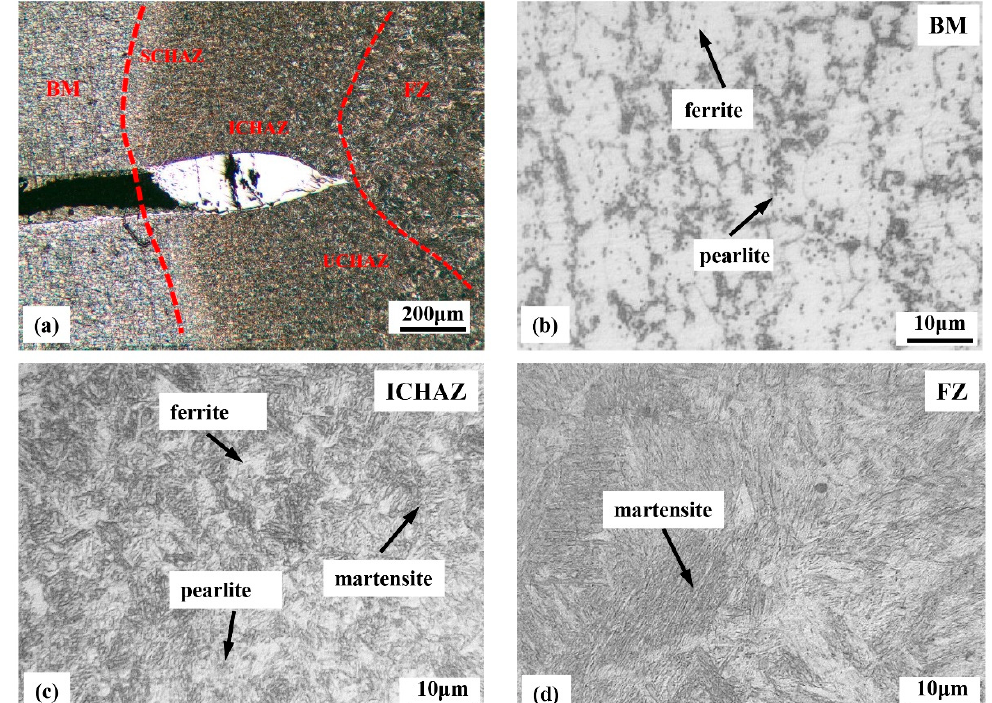
Figure 3. Microstructures of the O welding spot: ( a ) overview of the welded joint; ( b ) base metal; ( c ) intermediate critical heat-affected zone; ( d ) fusion zone.